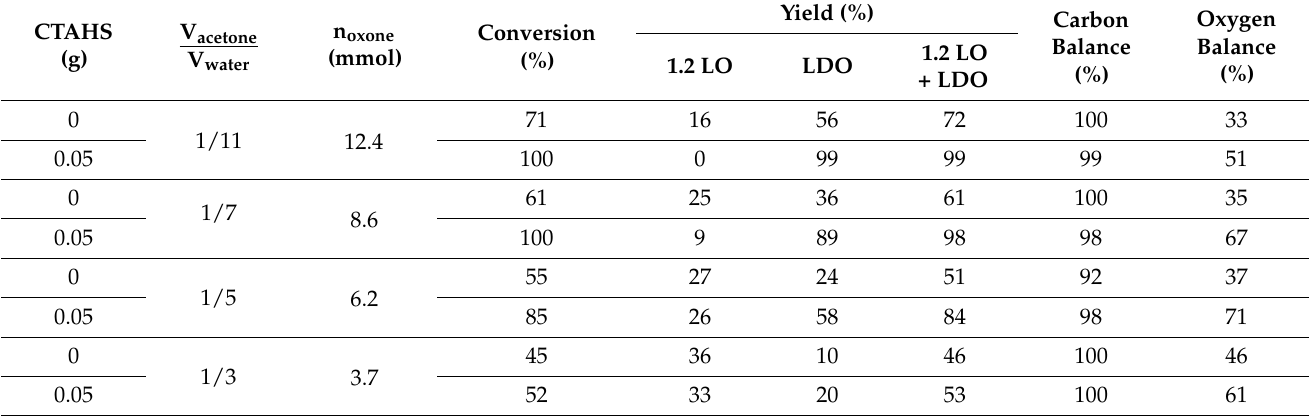
Table 2. Epoxidation of limonene in presence and absence of CTAHS [48].